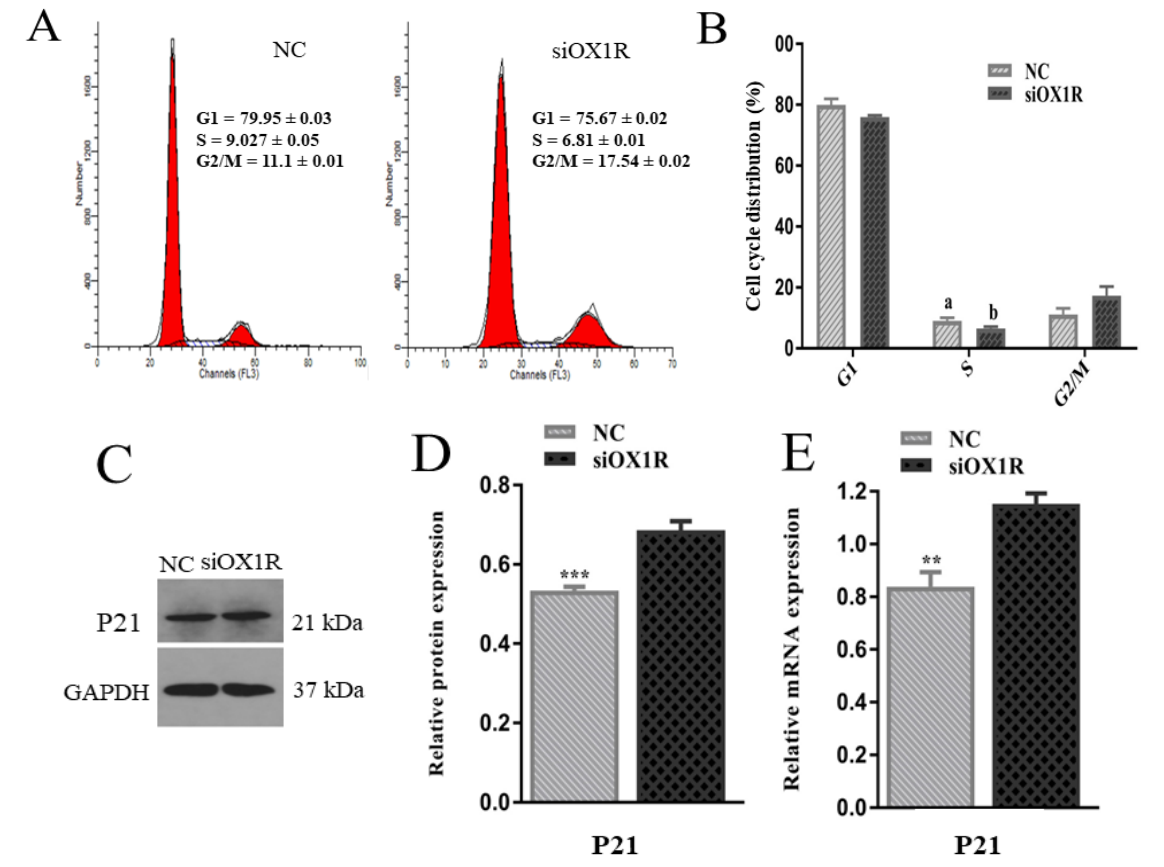
Figure 5. OX1R silencing induced S-phase arrest of the cell cycle in mouse GCs. ( A ) Measurement of the cell cycle progression using flow cytometry in mouse GCs after transfection with siOX1R for 48 h and ( B ) the cells distribution in different phases of the cell cycle. The significant difference (** p < 0.01) between different groups is shown with letters ‘a’ and ‘b’ within columns. ( C – E ) The expression of P21 at the mRNA and protein levels. The data are shown as the means ± SEM (** p < 0.01, *** p < 0.001). OX1R, orexin receptor type 1; NC, negative control; GC, granulosa cells; siOX1R, orexin receptor 1 siRNA; FACS, fluorescence-activated cell sorting.